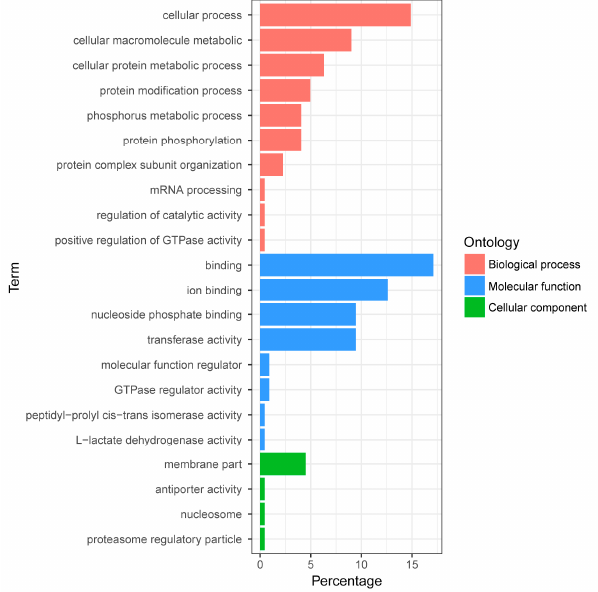
Figure 4. GO enrichment analysis of the differentially-phosphorylated phosphoproteins in A. Figure 4. mongolicus roots.